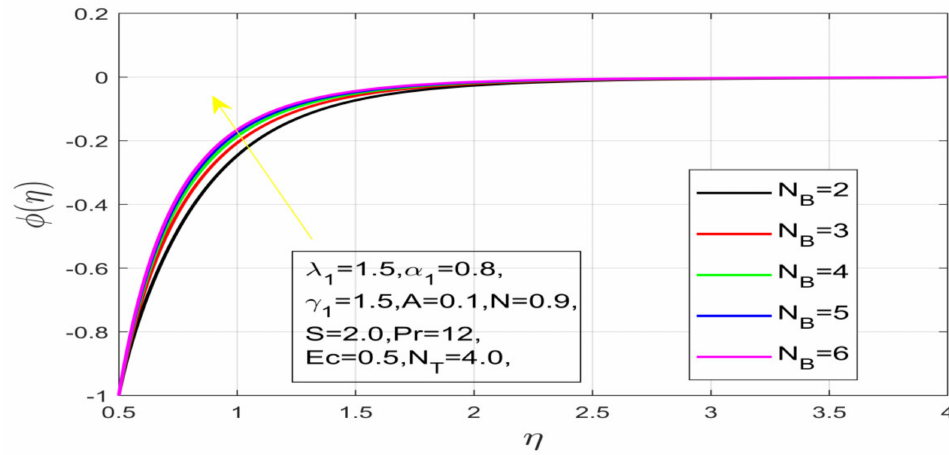
Figure 17. Contact of λ _1 on concentration.